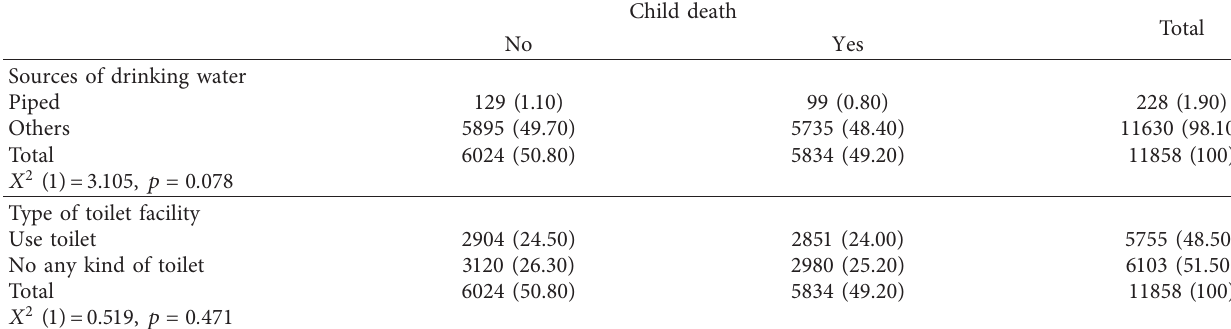
Table 9: Sources of drinking water and toilet facility on child mortality.